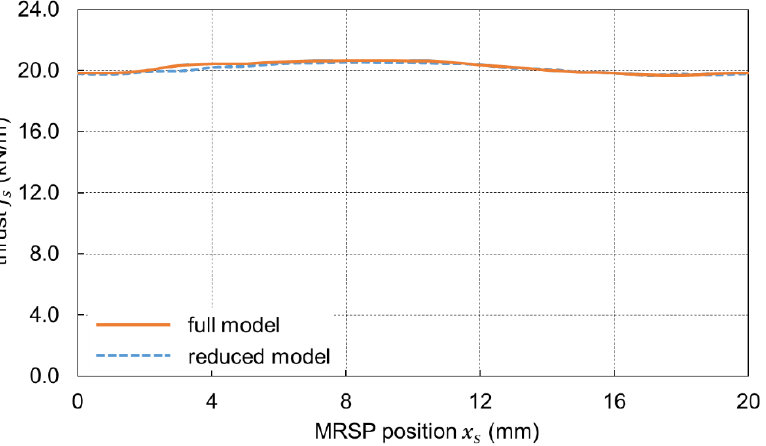
Figure 11. Pu depth thrust as a function of the position 𝑥 𝑠 calculated by means of the full and the reduced models ( 𝑛 𝑠′ = 7).